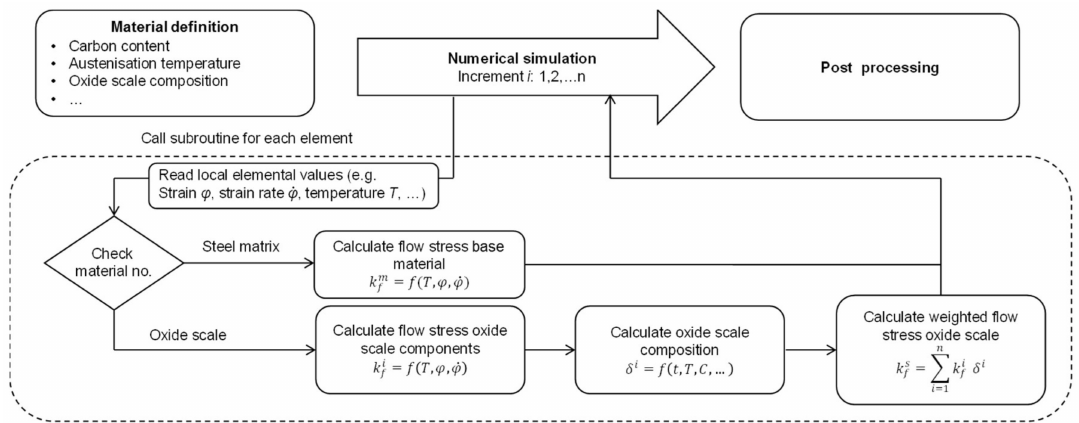
Figure 1. Information flow in the user-defined